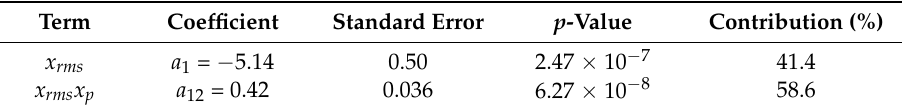
Table 5. The regression coefficients, standard errors, p -values, and contributions for the model of hardness with the ground sample data set. The intercept term is a 0 = 685.83.